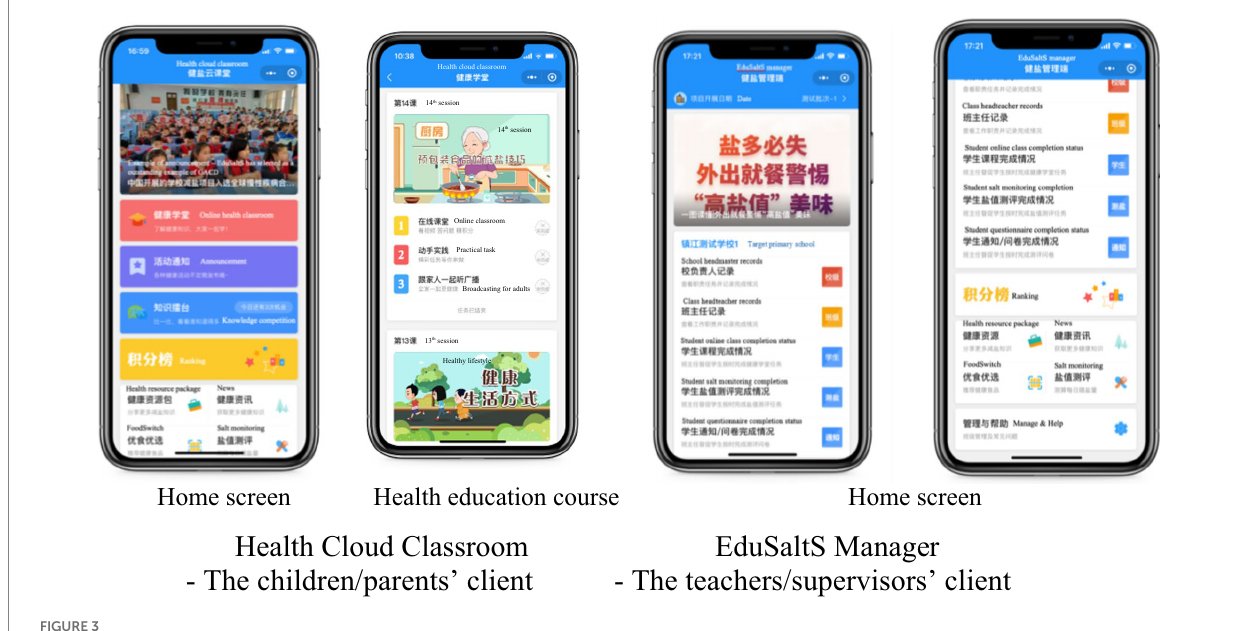
FIGURE 3 The main features of ‘Health Cloud Classroom’ and ‘EduSaltS